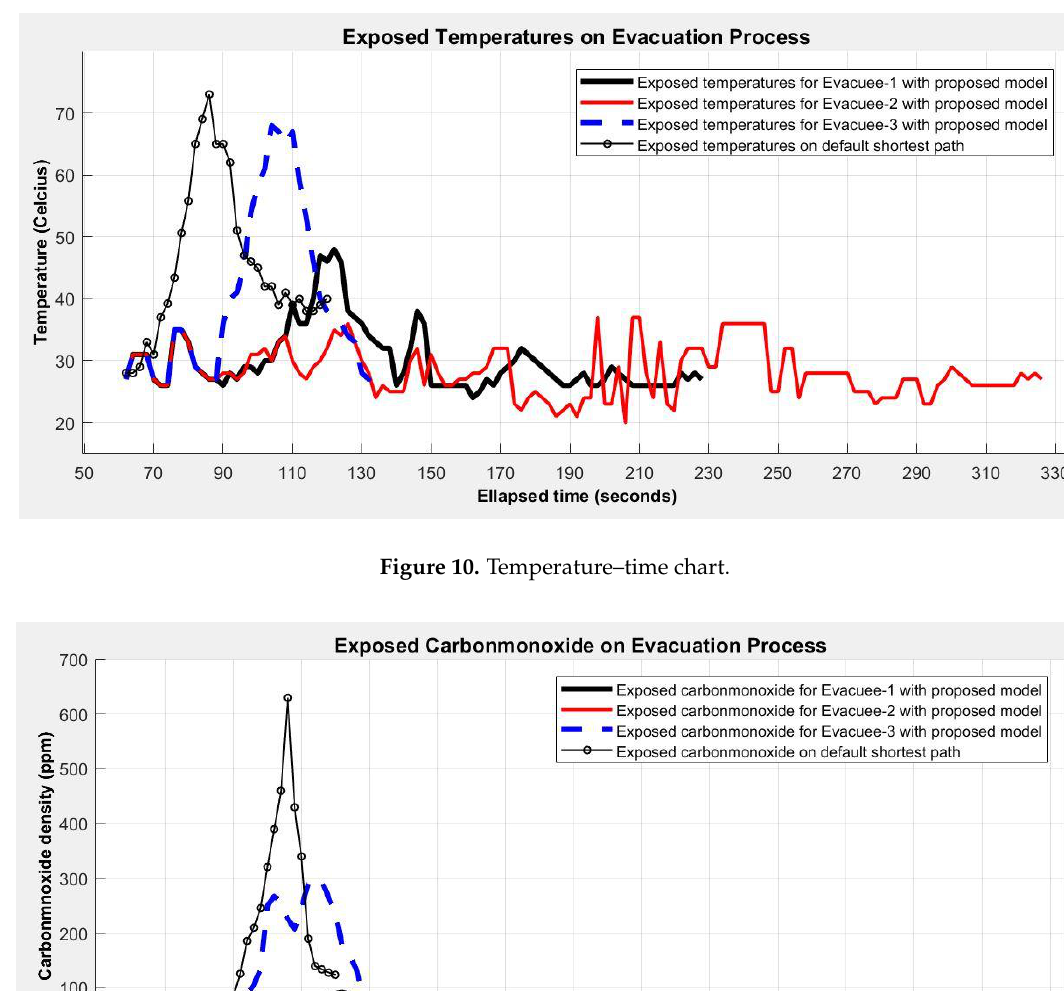
Figure 12. Visibility–time chart.